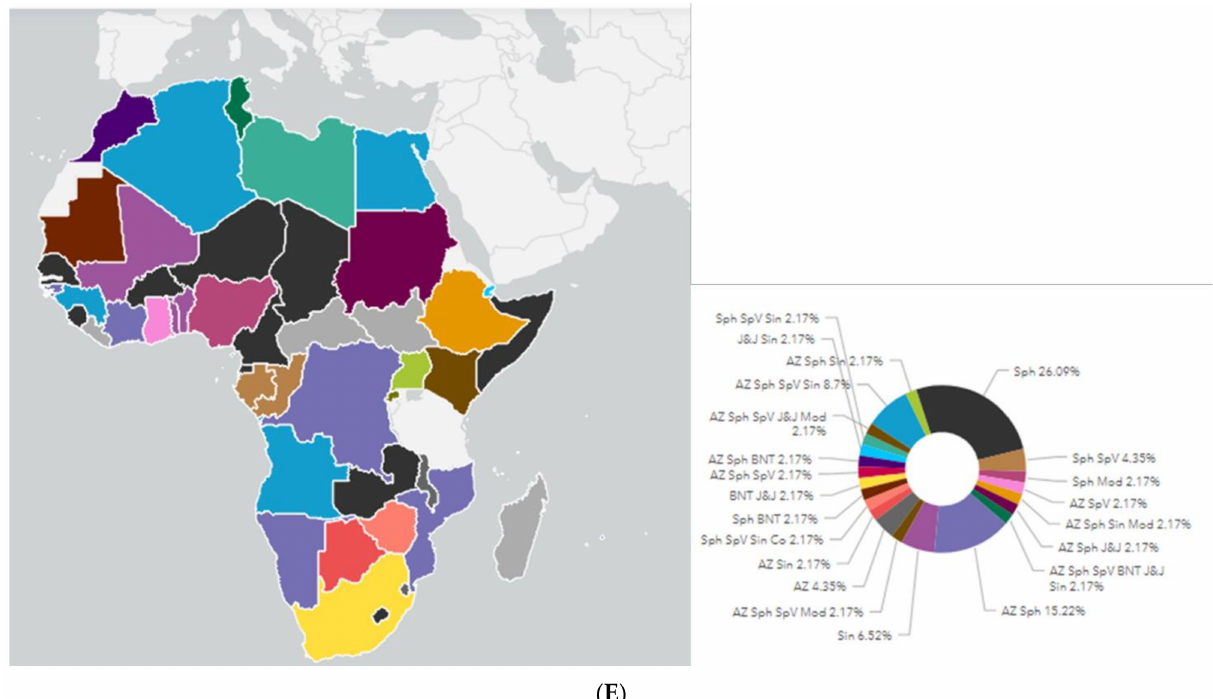
Figure 1. COVID-19 vaccine distribution in Africa until 30 June 2021. ( A ) A map showing the number of doses applied to each country. ( B ) A map showing the types of vaccines distributed to each country. ( C ) A map showing the countries received COVAX vaccines. ( D ) A map showing the countries received AVATT vaccines. ( E ) A map showing the countries received vaccines bilaterally; (AZ: AstraZeneca, Sph: Sinopharm, SpV: Sputnik V, BNT: BioNTech, Sin: Sinovac, Mod: